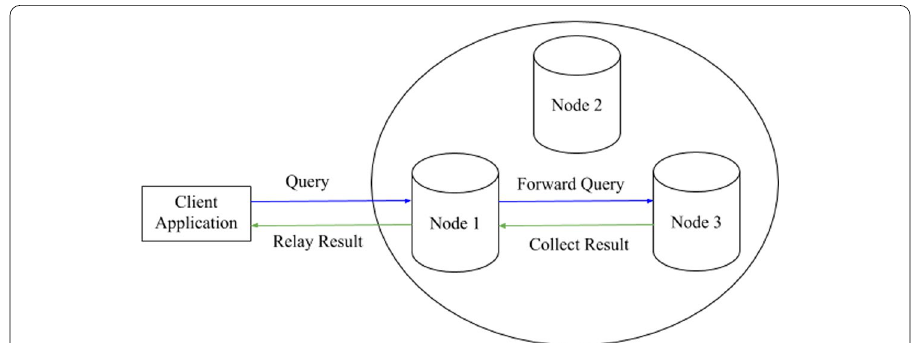
Fig. 1 Query execution path when cluster node does not own partition of data requested by